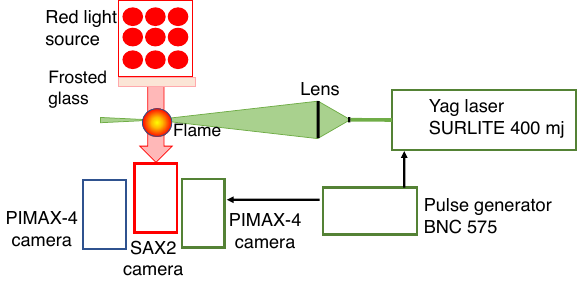
Figure 2. Schematic presentation of the optical setup. A YAG Surelite 400 mJ Continuum laser at 532 nm wavelength is used for the light scattering on the solid particles. A set of two lenses creates a laser sheet of 70 mm height and about 300 µ m thickness, which passes through the burner central axis. The scattered light is captured by a PIMAX4 camera (Teledyne Princeton Instruments, Trenton, NJ, USA) (1024 × 1024 pixels) equipped with a Nikon lens 100F/1.8 and a 20 mm extension ring. It has a spatial resolution of 62 µ m/pixel. A FF01 530 nm FWHM 11 nm filter (Semrock, Rochester, NY, USA) allows the observation of only light scattering. Both the camera and the laser are synchronized via a pulse generator BNC575 (Berkeley Nucleonics Corp, San Rafael, CA, USA). The images are captured with no delay and a gate width of 15 ns. A second Teledyne Princeton PIMAX camera equipped with a Sodern UV lens 100F/2.8 is used for measurements of flame global spontaneous emission as well as CH* and OH* emissions. The spatial resolution is 95 µ m/pixel. For flame global spontaneous emission, no filter is used on the camera and the exposure time is adjusted in order to not saturate the gray levels (5 µ s). Regarding the OH* spontaneous emission, an Asahi 310 nm filter (96SA02), FWHM 10.00 nm is used in front of the camera lens. The exposure time is 30 µ s. For CH* spontaneous emission, an Asahi 430 nm filter (F0102), FWHM 10.00 nm filter is used and an exposure time of 15 µ s is